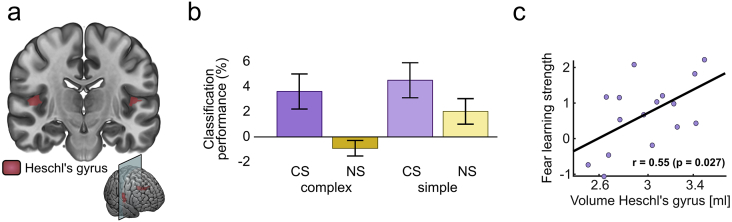
MVPA results. Error bars show standard error of the mean (SEM). (a) Regions of interest based on an anatomical atlas were HG and amygdala (not shown). (b) In HG, decoding of CS+/CS- was higher than for pairs of NS. Results are collapsed across hemispheres. (c) HG size predicts fear learning for complex sounds.